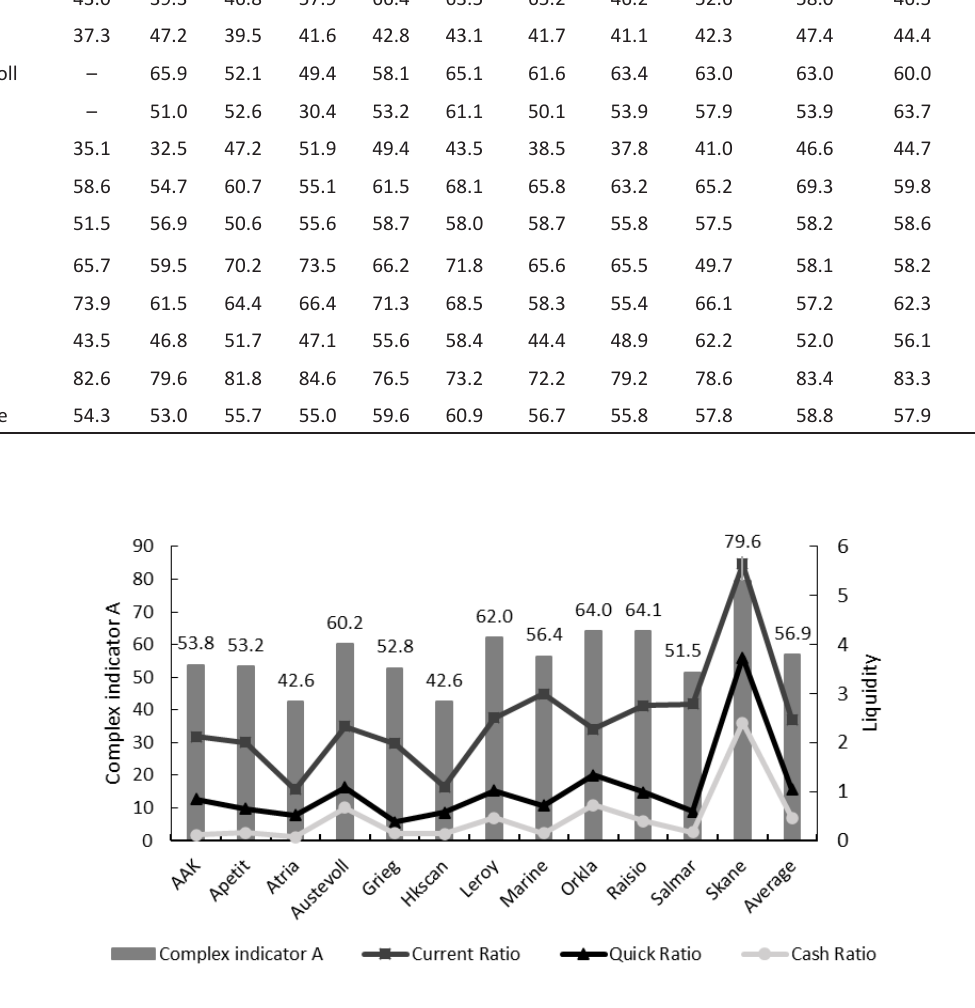
Fig. 6. The average values of complex indicator of strategies for working capital management (A) versus liquidity ratios of food companies from Northern Europe in